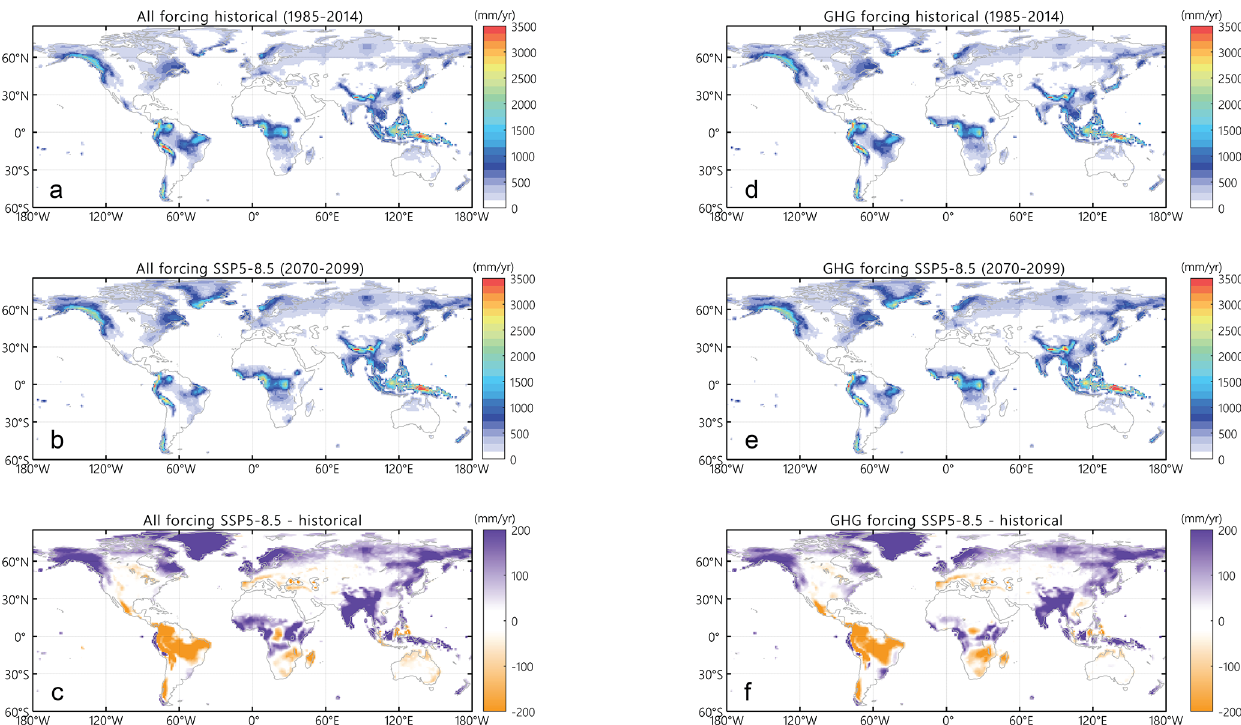
Figure 14. (a–c) Annual mean runoff (mmyr − 1 ) from (a) five historical ensemble simulations (1985–2014), (b) five SSP5.85 ensemble simulations (2070–2099), and (c) the change between the time period of 2070–2099 and the period of 1985–2014. Panels (d) – (f) are the same as (a) – (c) except for three ensemble members of the E3SMv1.0 GHG-only